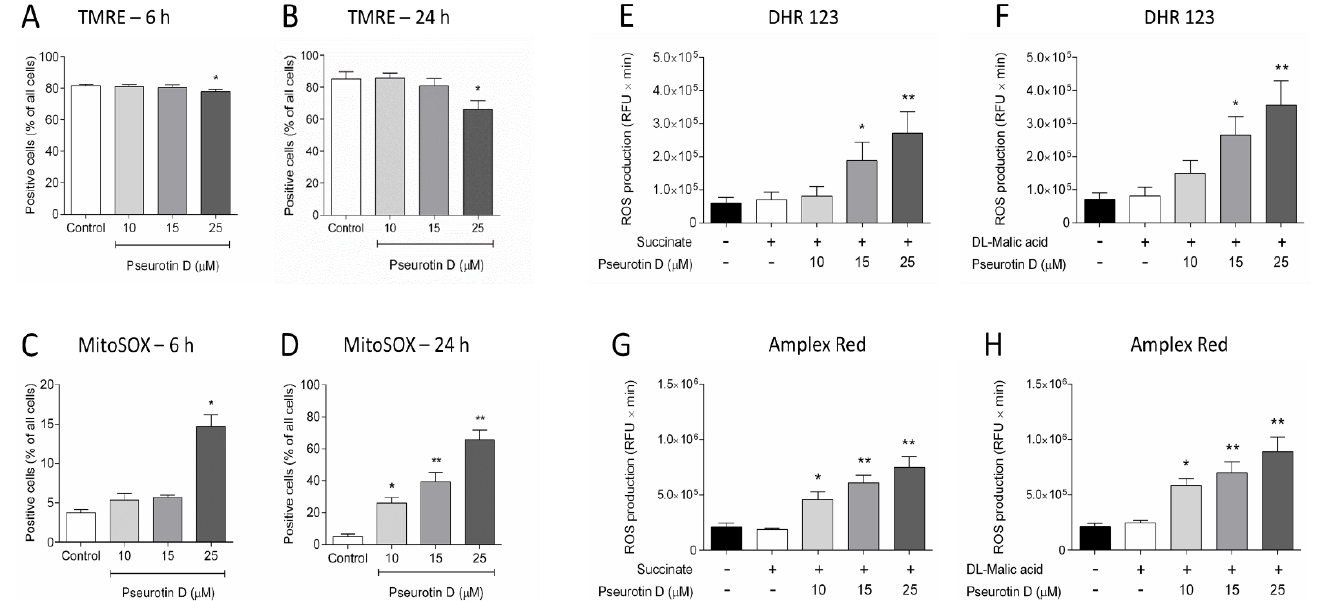
Figure 6. The effect of pseurotin D (10 – 25 µM) on MEC-1 mitochondrial membrane potential and mitochondrial ROS production. Cells were incubated with pseurotin D for 6 and 24 h, followed by an assessment of mitochondrial membrane potential ( A , B ) and mitochondrial ROS production ( C , D ). Isolated mitochondria were incubated with a combination of pseurotin D and substrate (succinate or malic acid) followed by the evaluation of ROS production using DHR-123 ( E , F ) and AmplexRed ( G , H ). Data were expressed as the mean ± SEM ( n = 3) and analyzed by ANOVA combined with Dunnett’s test (** p < 0.01 and * p < 0.05).